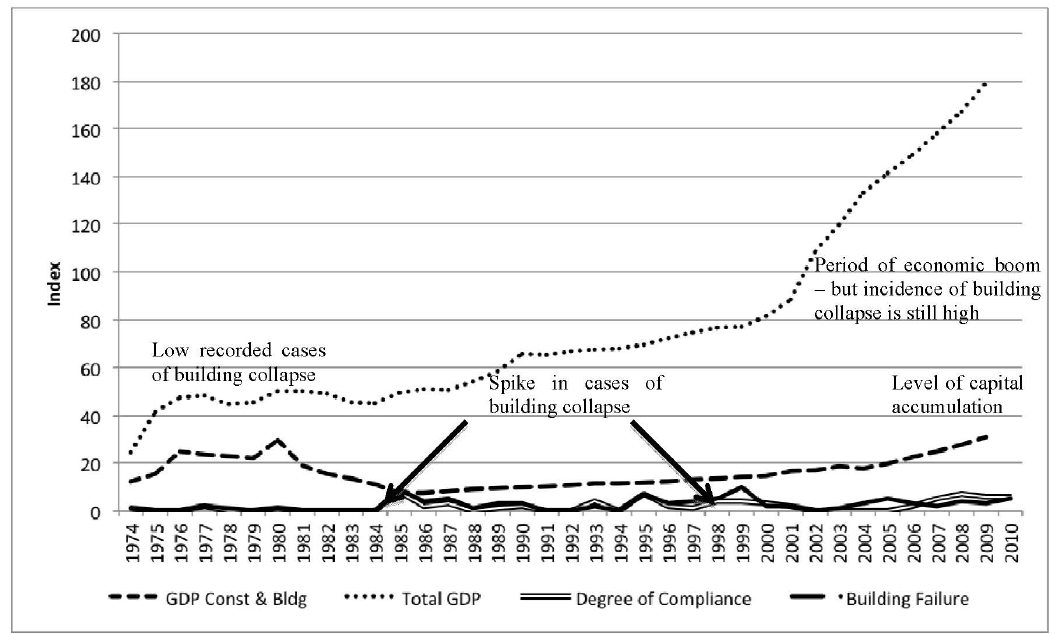
Figure 3. Real GDP, GDP construction and building, building collapse and assessed degree of compliance to sustainable construction principles in Nigeria from